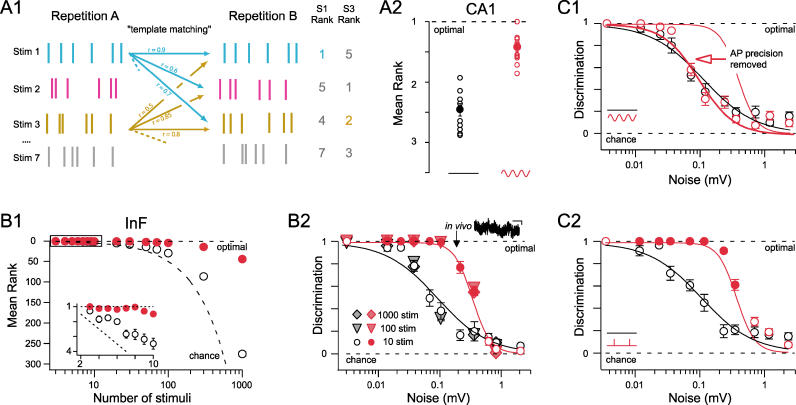
Oscillations Boost Stimulus Discrimination by Optimizing AP Precision(A1) Scheme showing the template-matching discrimination analysis: Spike trains of repetition A are correlated to trains from repetition B. Correlation coefficients are ranked and the rank of the correct match indicates level of discrimination: Examples shown are perfect (stimulus 1, highest correlation coefficient between 1A and 1B → rank 1) and near-perfect (stim. 3, second-highest correlation coefficient for 3A and 3B → rank 2).(A2) Stimulus discrimination plotted as the mean rank for the ten most separable stimulus sets from a single CA1 cell in vitro under control (no oscillation) and oscillation conditions (
p < 10
−12 for all
n = 135 stimulus sets in
n = 3 cells).
(B1) Stimulus discrimination plotted as mean rank as a function of stimulus number in simulation in an InF neuron. Inset: Mean rank scores for low numbers of stimuli. For all panels, filled red circles indicate where the discrimination for the oscillation case is significantly better than the respective control discrimination (
p < 0.05, Mann-Whitney). Dotted lines indicate perfect and chance levels of stimulus discrimination.
(B2) Discrimination in an InF neuron is plotted against injected noise levels (Gaussian noise, low pass filtered at 830 Hz, value given is SD of membrane potential) for ten (circles), 100 (triangles), and 1,000 (diamonds) stimuli with (red) and without oscillatory current injection (black open circles, black/gray-filled triangles and diamonds). Solid lines are sigmoidal least square fits. The inset trace (top right) is an example of the in vivo membrane potential (recorded in the presence of TTX) used to estimate realistic noise levels (arrow). This level of noise is used in all simulations unless otherwise stated. Scale bar is 200 ms and 200 μV. Dotted lines indicate optimal and chance levels of stimulus discrimination.(C) Increased discrimination in InF neurons is due to enhanced AP precision. (C1) AP precision was measured for control and oscillation cases. The difference in AP precision was subtracted (jitter was added to the output spikes as described in
Materials and Methods) from the oscillation case so that overall AP precision was identical to control conditions and the simulation was re-run. The sigmoidal fit to both oscillation data (red) and control data (open circles) is plotted. Sigmoidal fits from B2 are provided for comparison.
(C2) In this simulation, the oscillatory drive was replaced by brief, large amplitude current injections every 250 ms to evoke precise APs. Discrimination is plotted as a function of membrane noise and is indistinguishable from the oscillation case [F
(1,120) = 1.32,
p > 0.25]. Lines indicate best fits of the discrimination data for oscillation and nonoscillation conditions shown in B2.